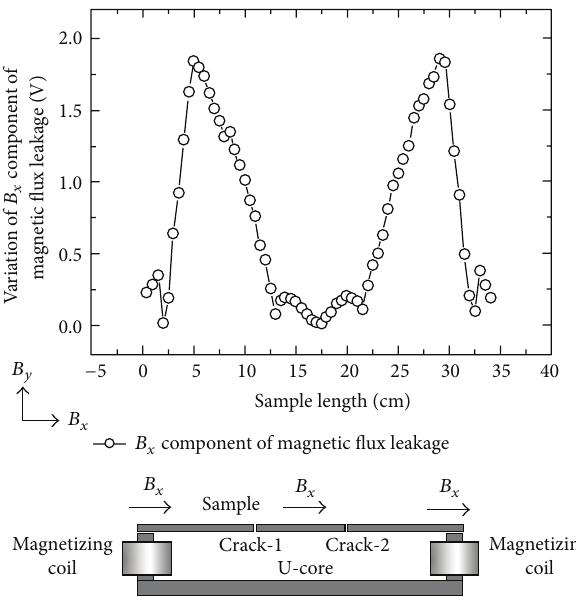
Figure 10: Measurement of 𝐵 𝑥 component of the magnetic flux leakage with sample between core legs with two cracks. The 𝐵 𝑦 component is higher at about core legs then gets lower between core legs at the first crack as shown in Figure